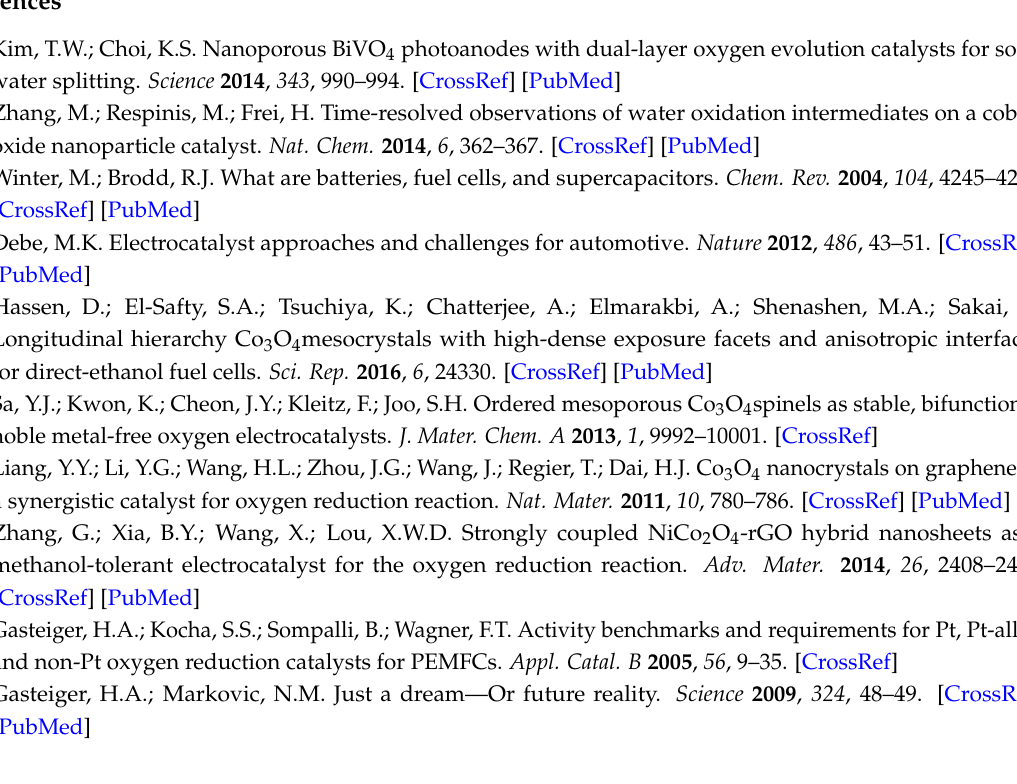
Figure S1: (A–D) Top-view FE-SEM micrographs of the as-prepared fibers recorded at different locations, (A,B) SEM images of electrospun NiCo 2 O 4 nanofibers and (C,D) SEM images of electrospun C/NiCo 2 O 4 hybrid nanofibers; Figure S2: WA-XRD patterns of (a) C/NiCo 2 O 4 composite nanofibers and (b) NiCo 2 O 4 nanofibers; Figure S3: (A,B) RDE voltammograms collected in O 2 saturated 0.1 M KOH solution at various rotational speeds of (A) C/NiCo 2 O 4 catalyst and (B) commercial Pt/C catalyst; (C,D) The corresponding Koutecky–Levich plots derived from the RDE voltammograms of (C) C/NiCo 2 O 4 hybrid catalyst and (D) commercial Pt/C